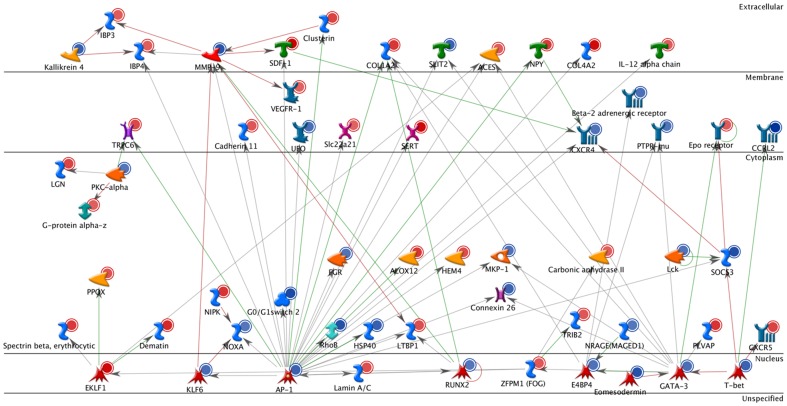
Interaction network of transcripts with significant change in DNA methylation at birth that show significant transcriptional change later in life upon the first encounter with allergen.Interacting factors are depicted in various shapes depending on their biological nature, connecting arrows indicate known links. Blue circles indicate transcripts down-regulated in asthma-at-risk DCs, red – up-regulated.